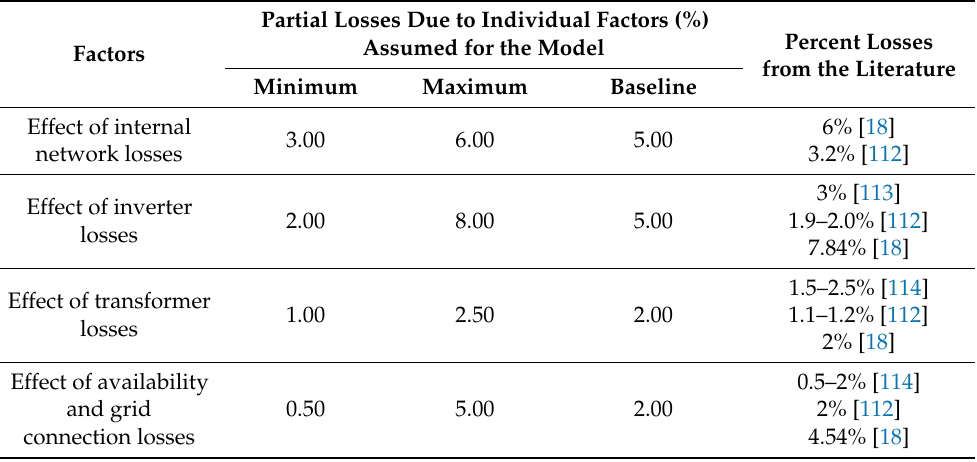
Table 3. Range of system derate factors assumed for the proposed prefeasibility PV